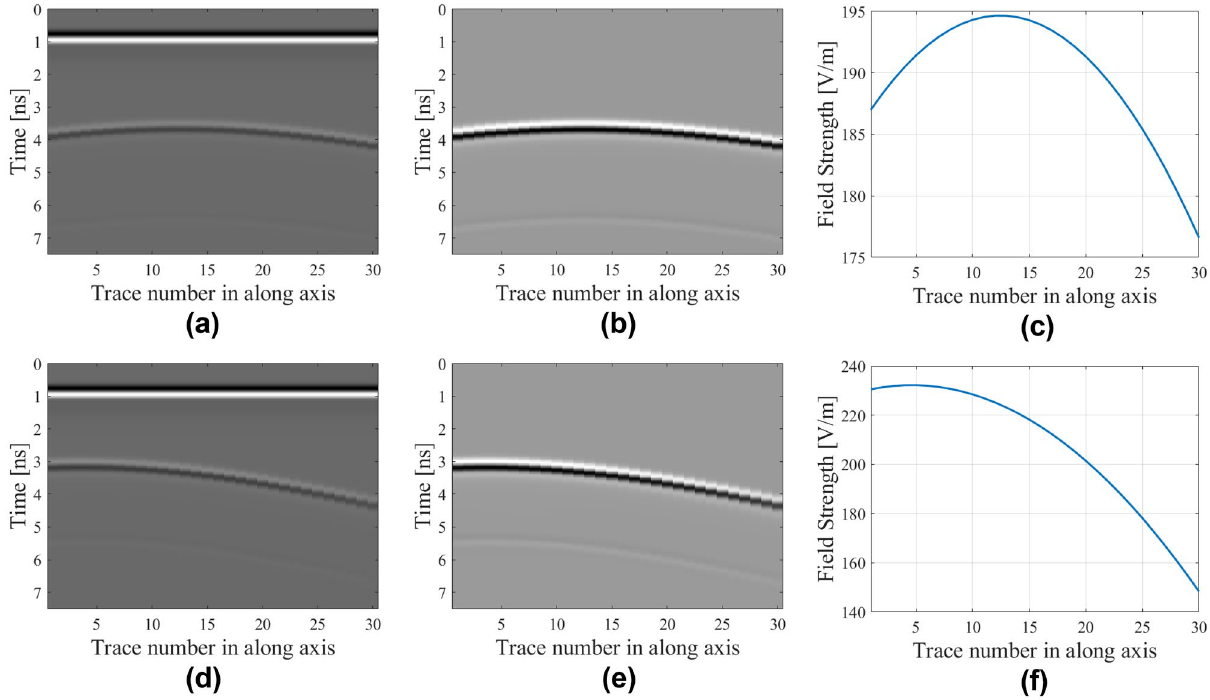
Figure 6. Raw and pre-processed B-scan data with their extracted hyperbolic patterns for selected samples concerning the following two test scenarios. The first scenario corresponds to D = 276 mm, P = 172 mm, and R = 33 mm: ( a ) raw B-scan image, ( b ) B-scan image with removed background reflections, ( c ) extracted hyperbolic pattern. The second scenario corresponds to D = 233 mm, P = 83 mm, and R = 34 mm: ( d ) raw B-scan image, ( e ) B-scan image with removed background reflections, ( f ) extracted hyperbolic